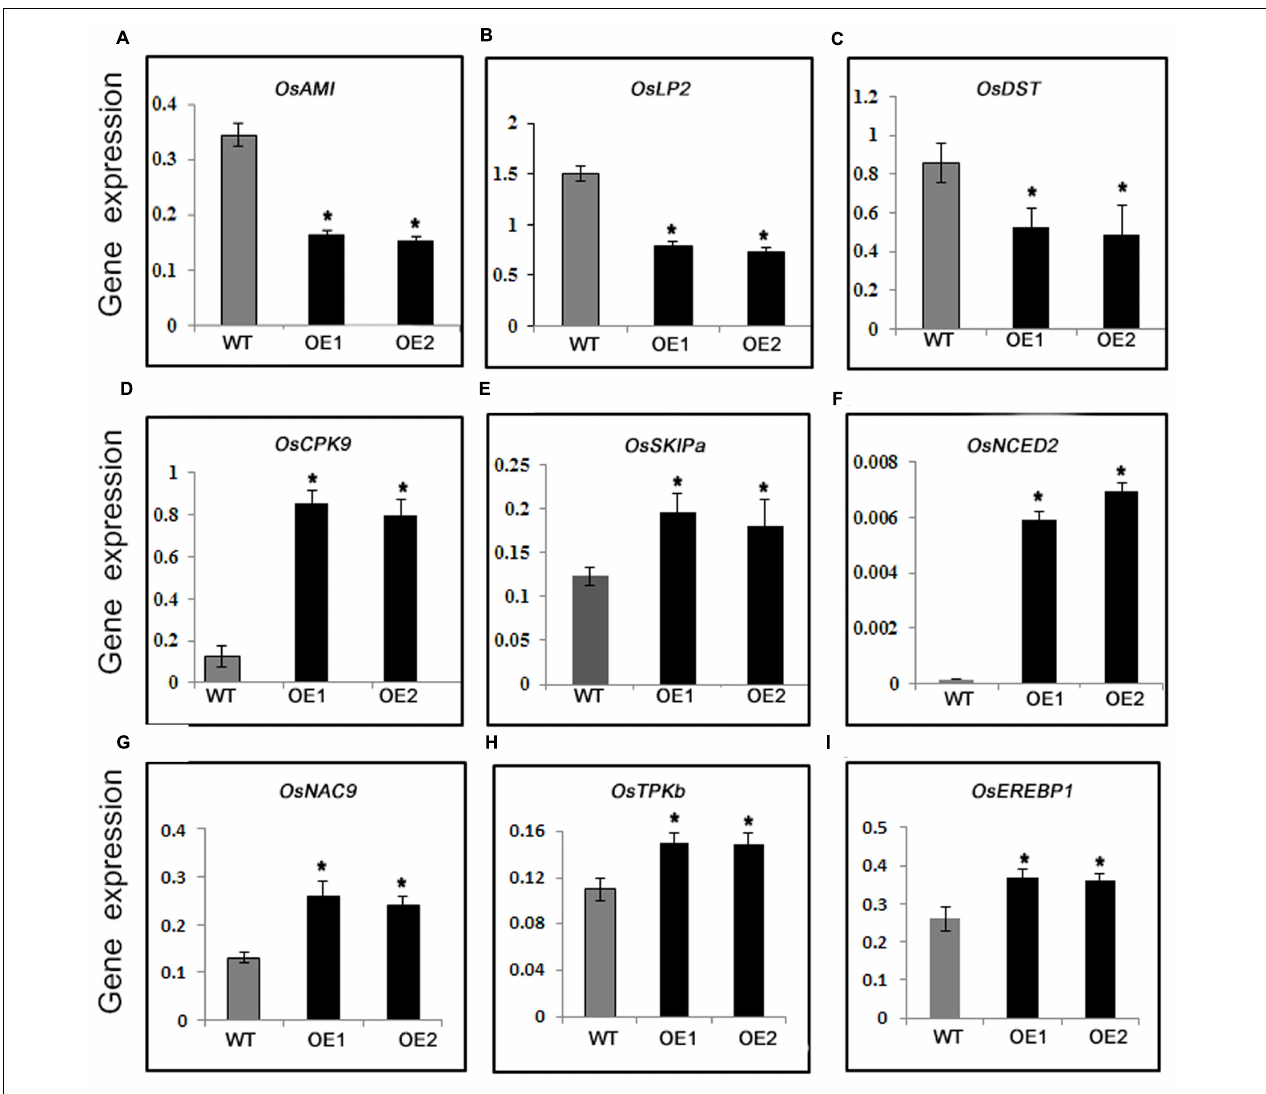
FIGURE 2 | Relative expression levels of drought-responsive genes in WT and PeaT1OE plants. The analyzed genes were OsAM1 (A) , OsLP2 (B) , OsDST (C) , OsCPK9 (D) , OsSKIPa (E) , and OsNCED2 (F) , OsNAC9 (G) , OSTPKb (H) , OsEREBP1 (I) . Data is presented as the mean ± standard deviation ( n = 9). Significant differences are determined with Student’s t -test ( ∗ 0.01 < P < 0.05, ∗∗ P <